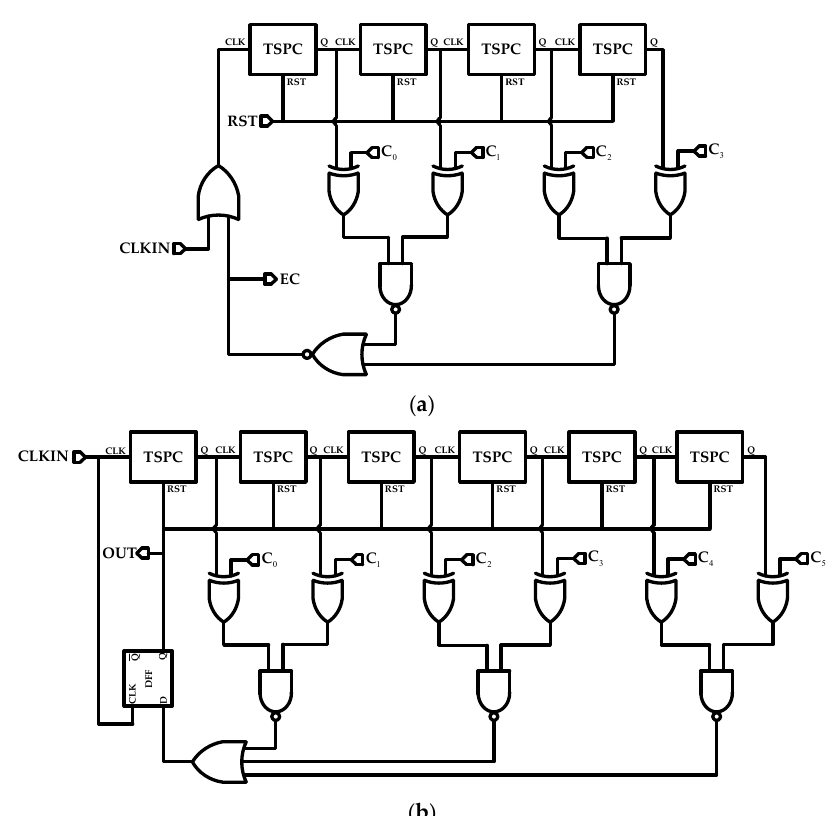
Figure 6. ( a ) Block diagram of counter S; ( b ) Block diagram of counter P.